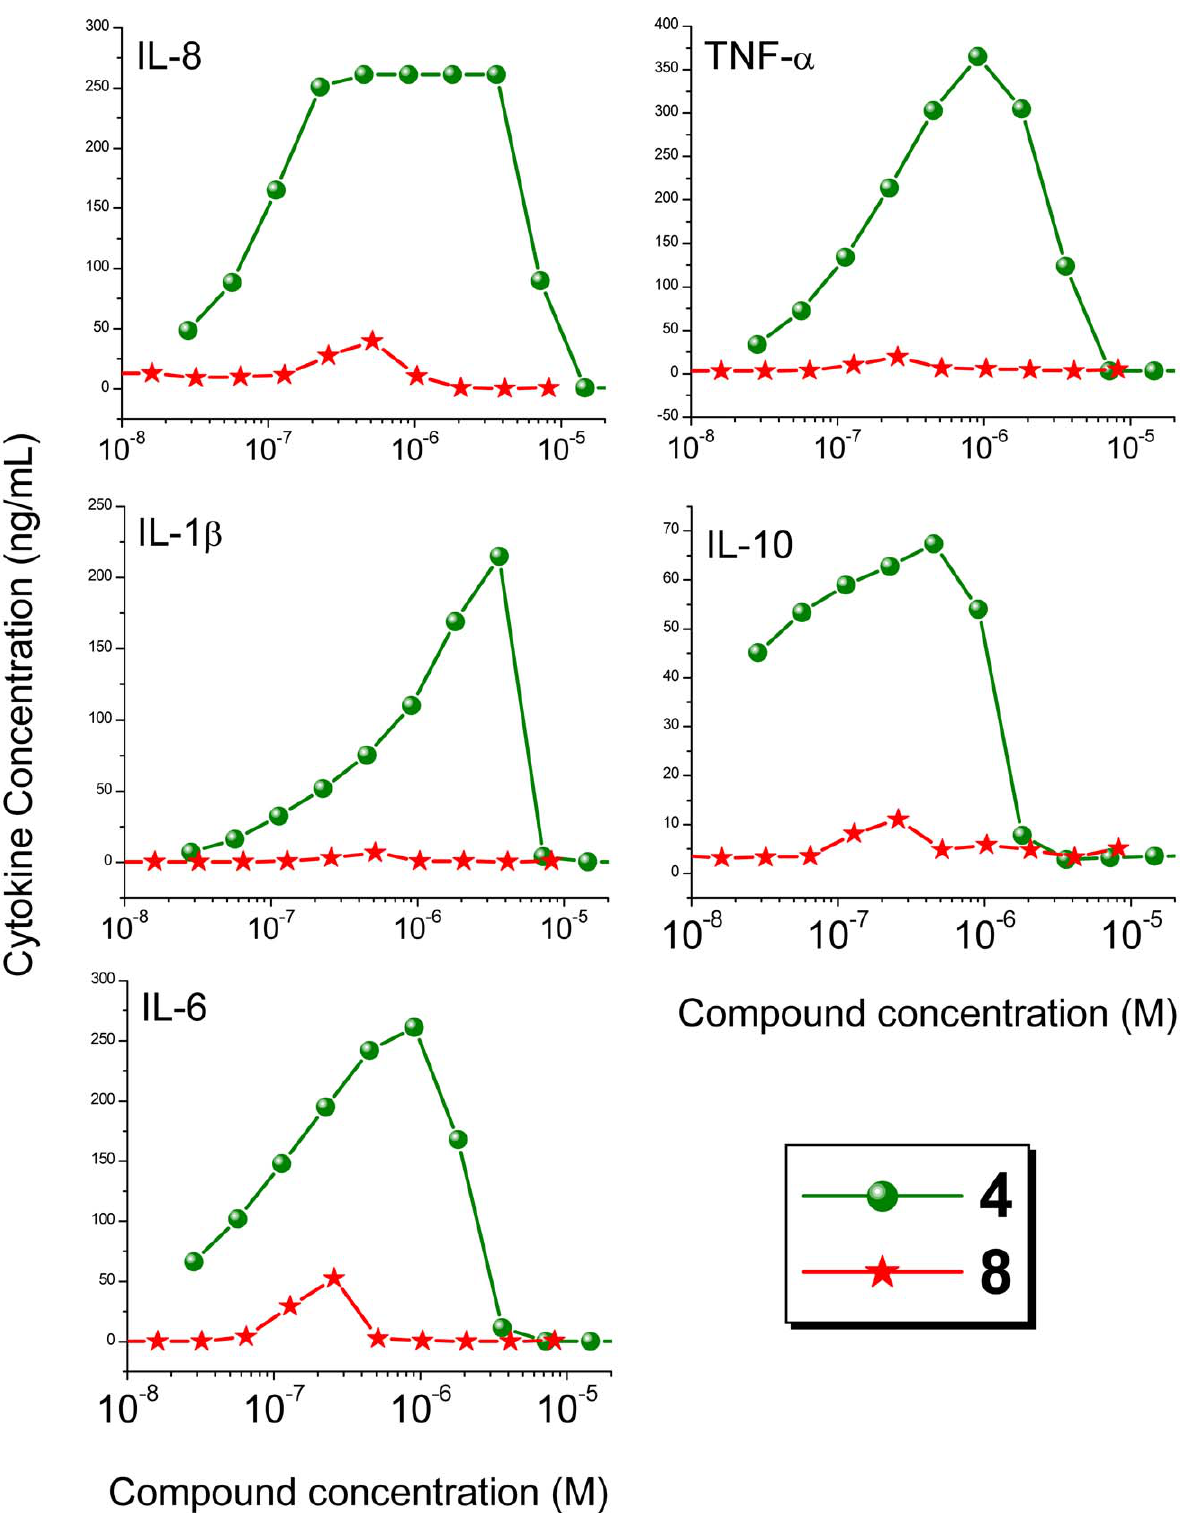
Figure 4. Cytokine induction by Compounds 4 and 8 in human PBMCs. Data points of dose-response profiles represent means of duplicates of three representative experiments. Cytokines were quantified using cytometric bead array assays. doi:10.1371/journal.pone.0043612.g004 organic layer was washed with water (2 6 20 mL), brine (2 6 20 mL) vacuum. The crude residue was column purified to afford and dried over anhydrous sodium sulfate and concentrated under compound 7 as thick liquid (433 mg, 58%). 1 H NMR